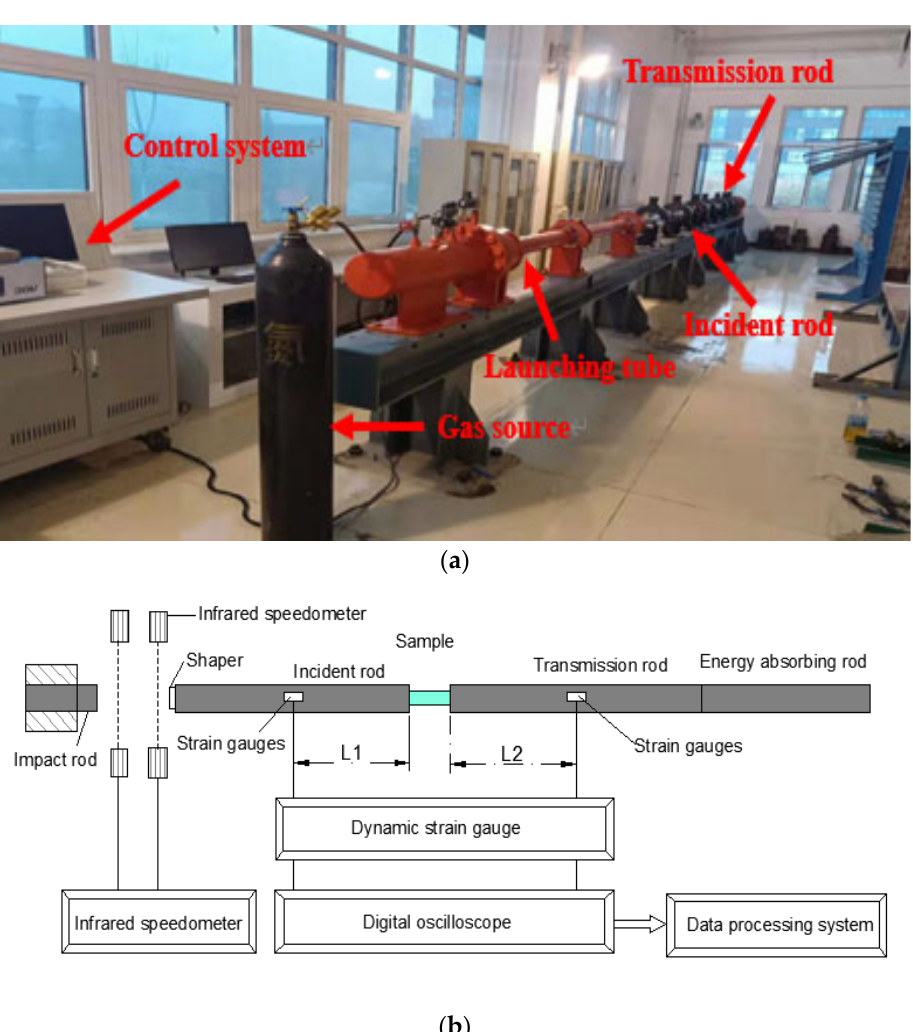
Figure 1. SHPB loading device and schematic diagram of dynamic test system. ( a ) SHPB loading device, ( b ) Schematic diagram of dynamic test system.